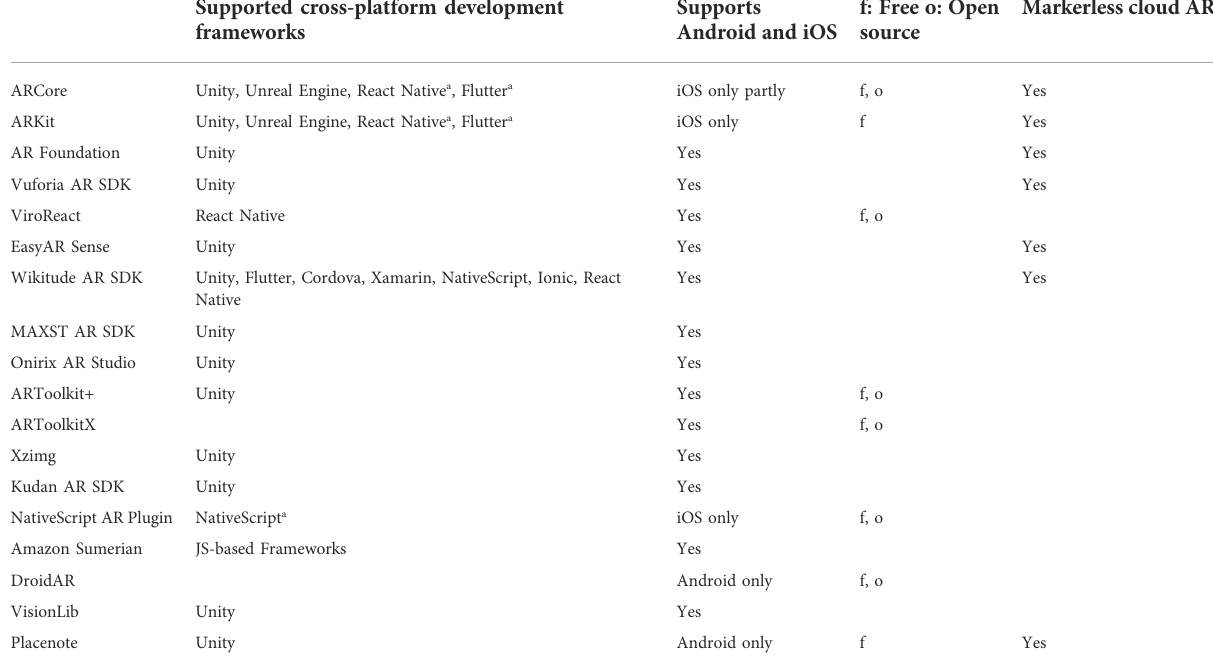
TABLE 1 Comparison of commonly used AR